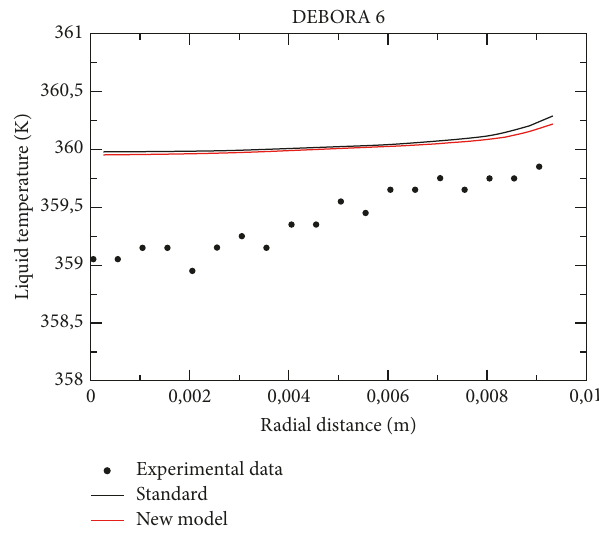
Figure 53: Liquid temperature, comparison of the new and the previous model for